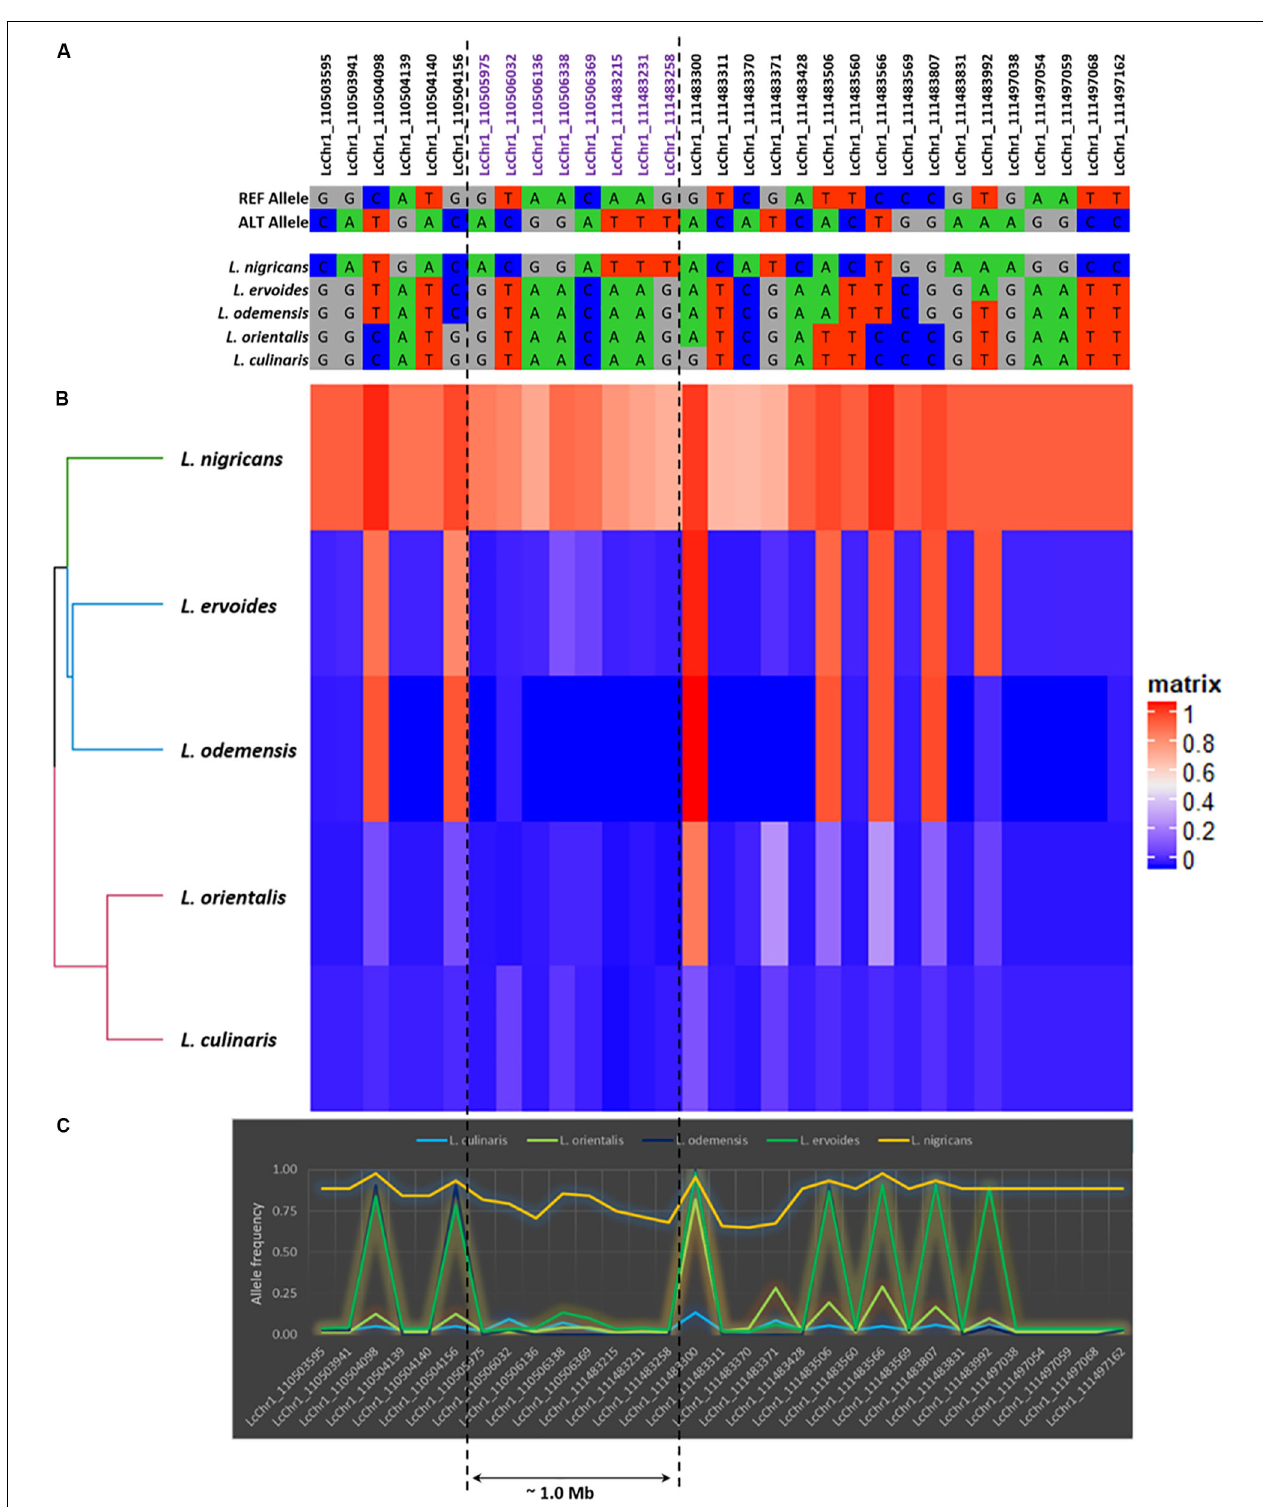
FIGURE 5 | The detailed illustration of the genetic polymorphism detected in LcChr1. (A) Allelic polymorphism. (B) Heatmap based on allele frequencies (in matrix, 1: Alternative allele and 0: Reference allele). (C) Graphical representation of the allele frequencies.